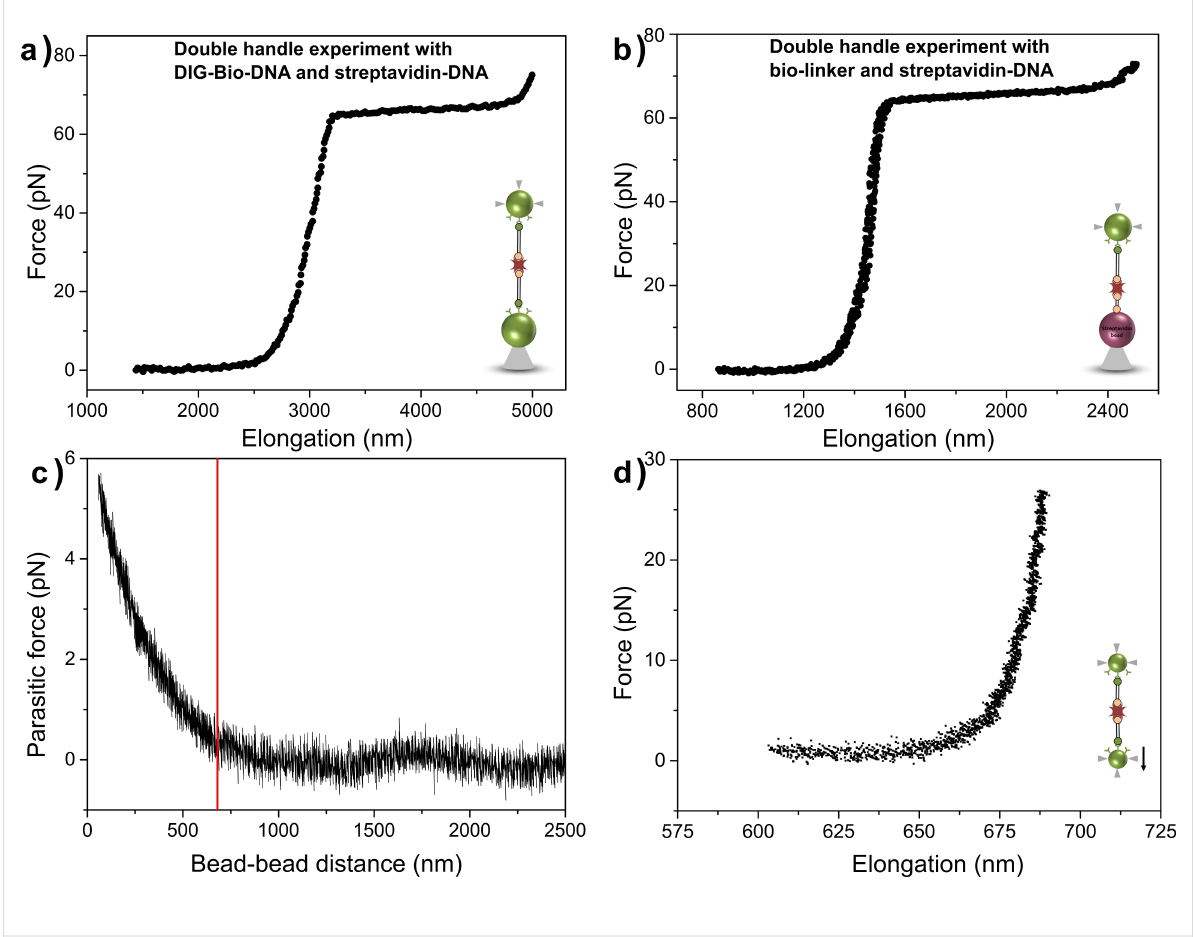
Figure 7: Characteristic force–extension curves of double-handle experiments. a) DIG-DNA-Bio and streptavidin-DNA, both tethered to anti-DIG beads (Figure 1d). With more than 1800 nm the plateau length was greater than 70% of the contour length of one DH, thus indicating a specific and stable connection between the two DNA molecules. b) Bio-linker modified streptavidin beads and streptavidin-DNA at anti-DIG bead with a plateau length of about 900 nm (Figure 1c). A stable tether was achieved, yielding a force–extension curve with a characteristic force plateau. c) Using dual- trap OT (Figure 1e) crosstalk is observed between two orthogonally polarized beams below a certain trap–trap distance (less than 700 nm separation betwenn the surfaces of the beads) due to polarization scrambling of the objectives resulting a parasitic signal. The red line indicates the optimum double DNA contour length of 680 nm (1000 bp each). d) Double-handle experiment using the dual-trap OT, where DHs and PDHs (1000 bp each) were tethered to small (0.84 μ m) beads and tethered in situ. The assembly was stable over time and featured the characteristic double-handle contour length of 680 nm at a tension of approx. 10